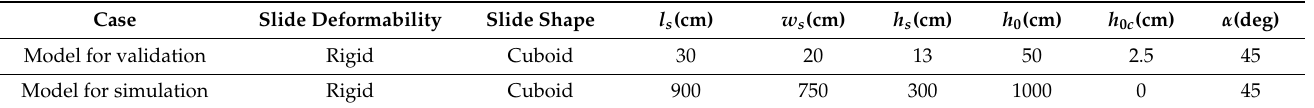
Table 1. Specific parameters of landslide model.